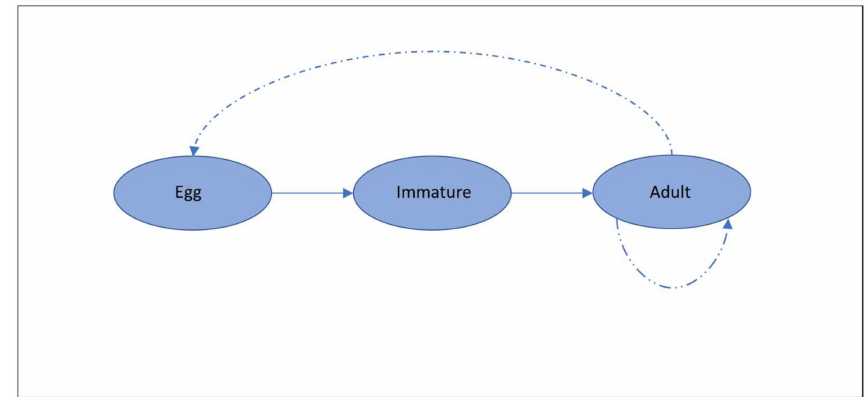
Figure 2. The life history of vernal pool fairy shrimp.